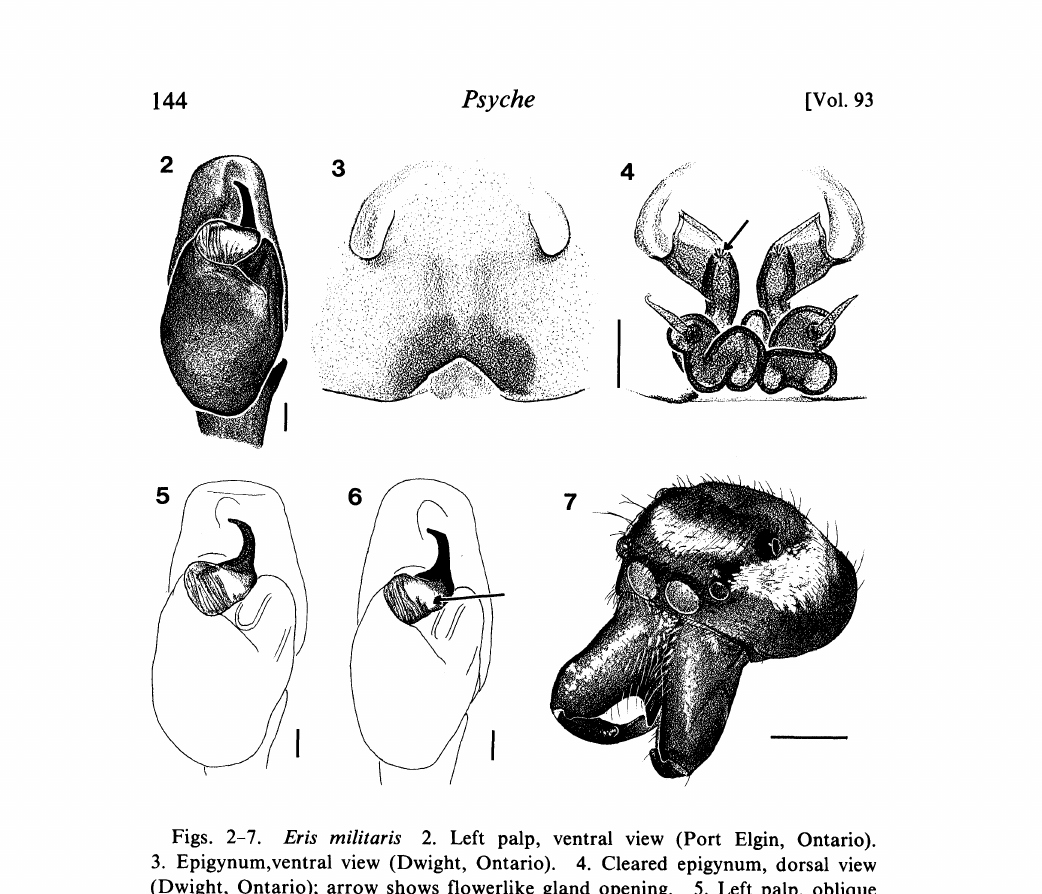
Figs. 2-7. Eris militaris 2. Left palp, ventral view (Port Elgin, Ontario). 3. Epigynum,ventral view (Dwight, Ontario). 4. Cleared epigynum, dorsal view (Dwight, Ontario); arrow shows flowerlike gland opening. 5. Left palp, oblique view from the ventral-retrolateral-distal (Pine Lake, Michigan), and 6. Same (For- syth, Georgia); arrow shows lack of wrinkles on retrolateral half of embolar base. 7. Male carapace and chelicerae (Walloon Lake, Michigan), oblique view. Scale bars 0.1 mm for 2-6; mm for